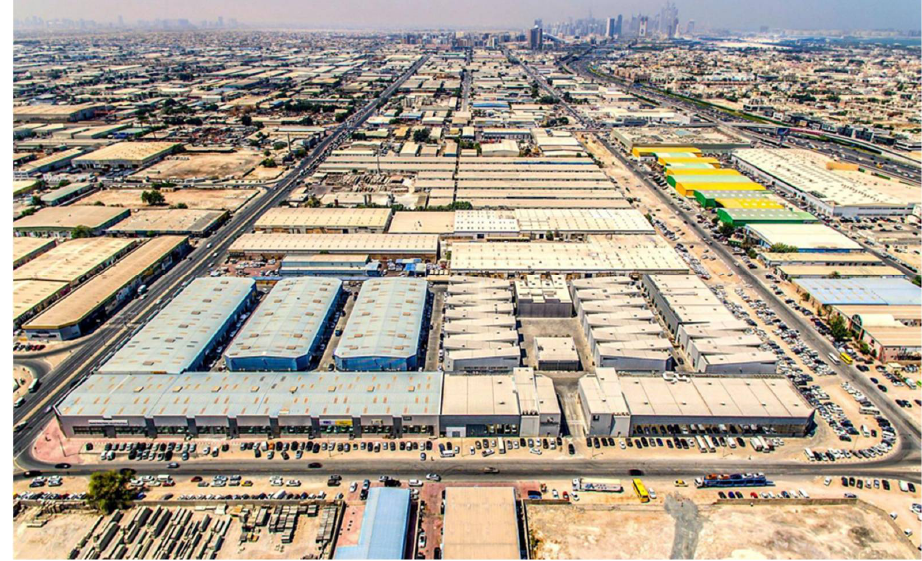
Figure 4. Aerial shot of Alserkal Avenue, 2017. Birds-eye-view of the art hub, with the original warehouses on the left and the newer expansion on the right. The view continues west towards Dubai Marina, over Al Quoz, with a view of Sheikh Zayed Road on the far right. Image courtesy of Alserkal